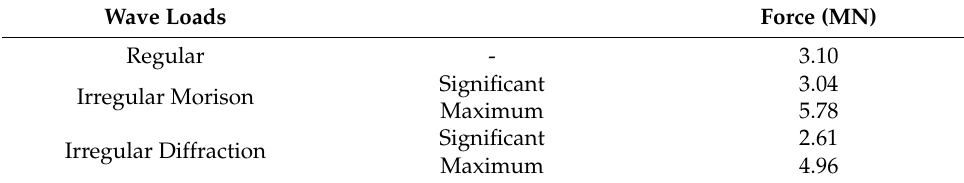
Table 3. Estimation on wave